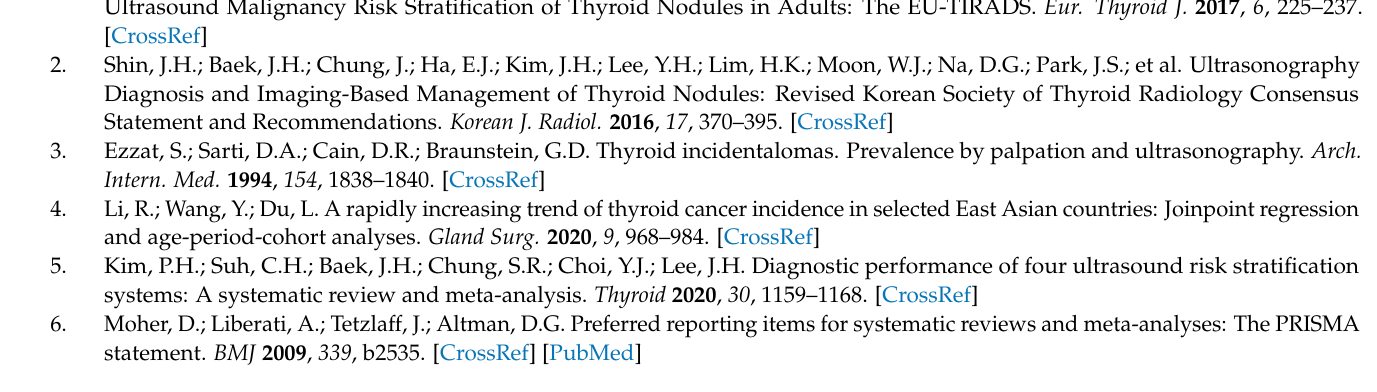
Systems; Supplementary Figure S1. Begg’s funnel plot for K-TIRAD; Supplementary Figure S2. Begg’s funnel plot for ATA; Supplementary Figure S3. Begg’s funnel plot for ACR; Supplementary Figure S4. Begg’s funnel plot for EU; Supplementary Figure S5. Begg’s funnel plot for Kwak-TIRAD; Supplementary Figure S6. Forest plot of the diagnostic odds ratio for ACR; Supplementary Figure S7. Summary receiver operating characteristic curve for ACR guidelines; Supplementary Figure S8. Forest plot of the diagnostic odds ratio for ATA; Supplementary Figure S9. Summary receiver operating characteristic curve for ATA; Supplementary Figure S10. Forest plot of the diagnostic odds ratio for EU; Supplementary Figure S11. Summary receiver operating characteristic curve for EU; Supplementary Figure S12. Forest plot of the diagnostic odds ratio for Kwak-TIRAD; Supplementary Figure S13. Summary receiver operating characteristic curve for